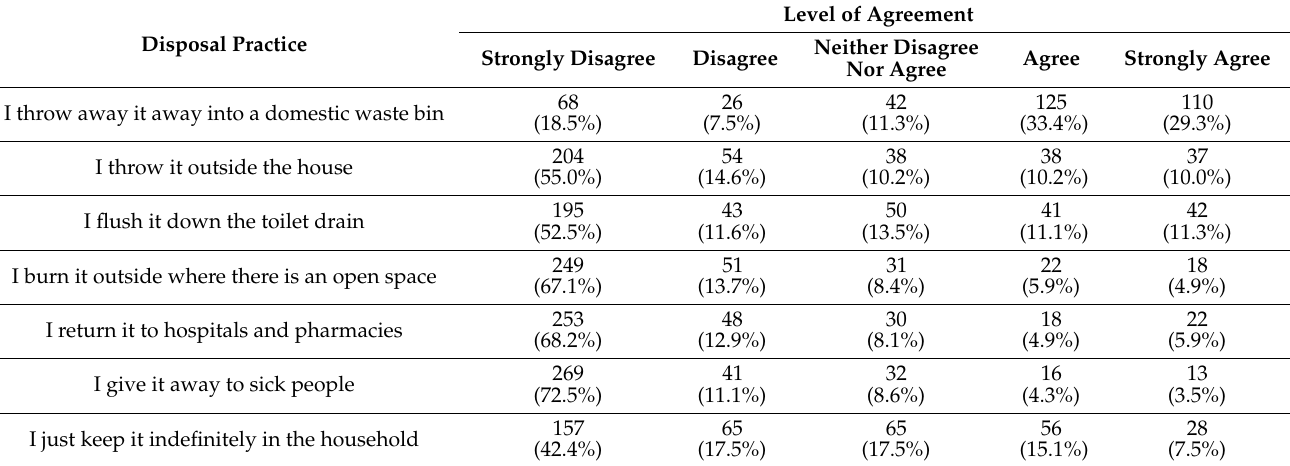
Table 4. Disposal practices for